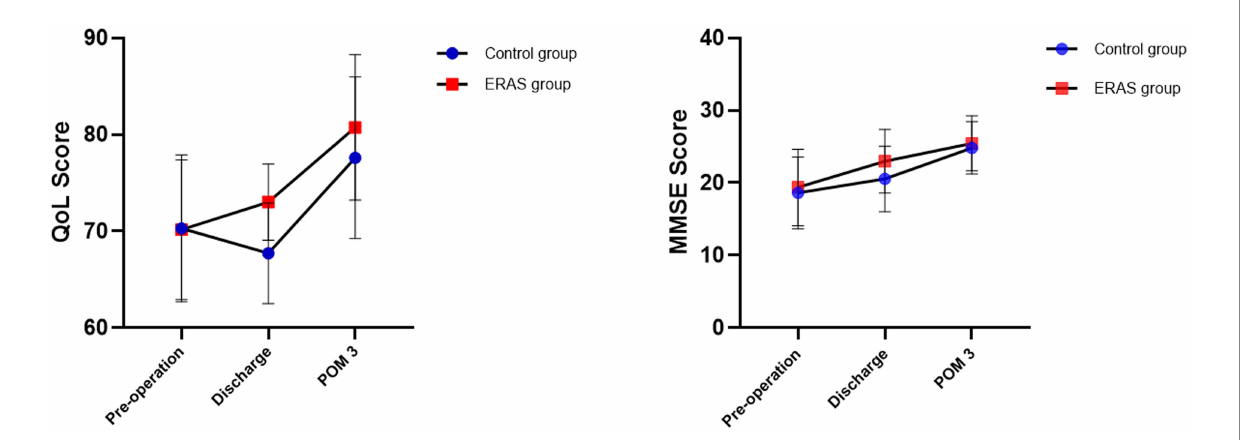
FIGURE 3 Comparison of MMSE and QoL scores between the two